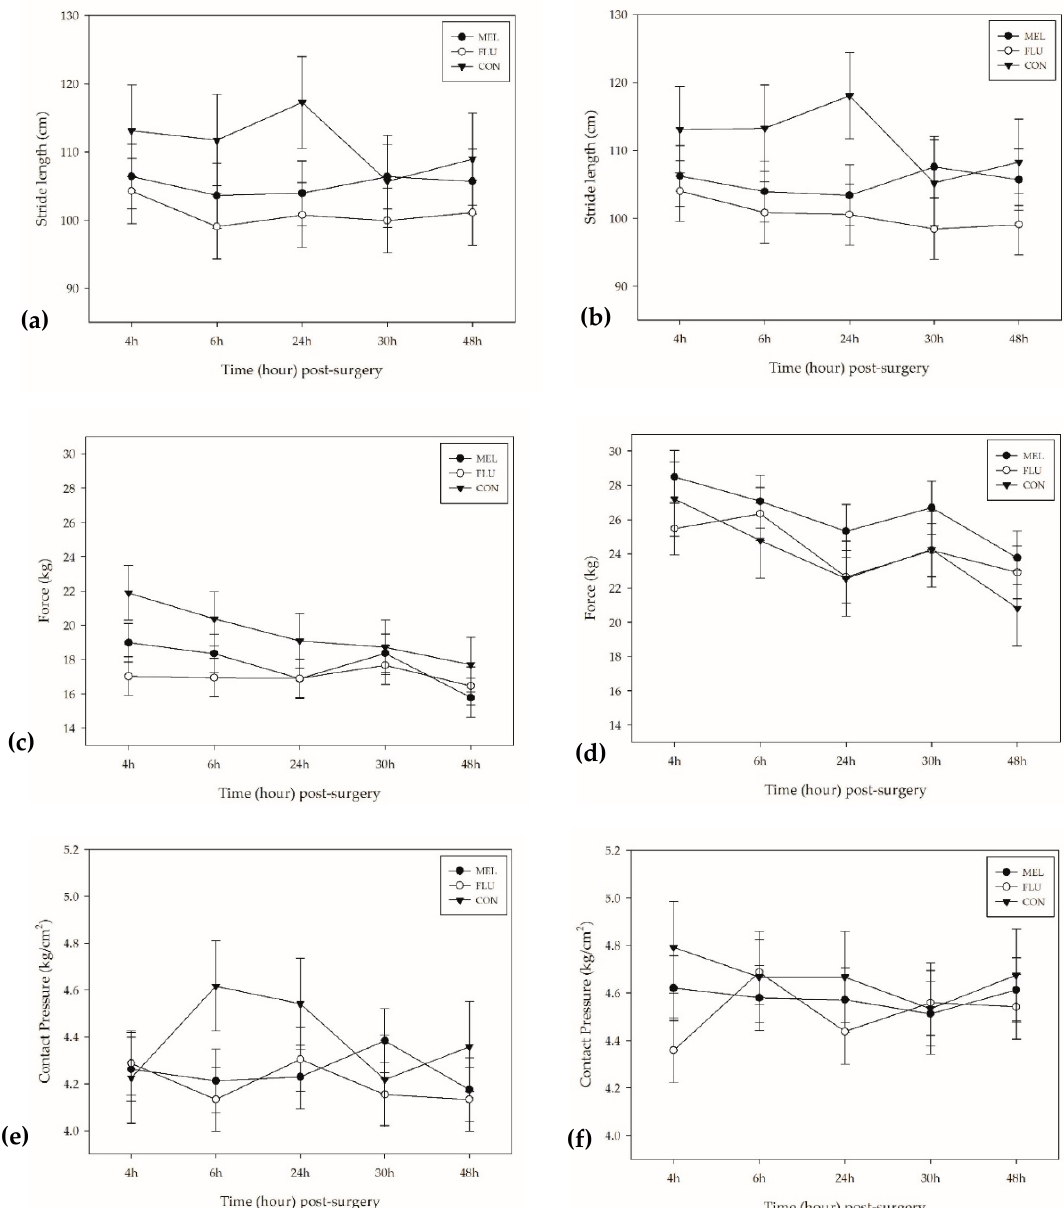
Figure 4. Mean (±SEM) over time for the following: ( a ) hind limbs stride length (cm); ( b ) front limbs stride length (cm); ( c ) hind limbs force (kg); ( d ) front limbs force (kg); ( e ) hind limbs contact pressure (kg/cm 2 ); ( f ) front limbs contact pressure (kg/cm 2 ). MEL = 2.0 mg/kg oral meloxicam pre-procedure and 1.0 mg/kg oral meloxicam at 24 and 48 h post-surgery ( n = 12 sheep); FLU = 2.2 mg/kg flunixin meglumine IV pre-procedure, at 24 and 48 h post-surgery ( n = 12 sheep); CON = non-surgical (control) group ( n = 6 sheep).